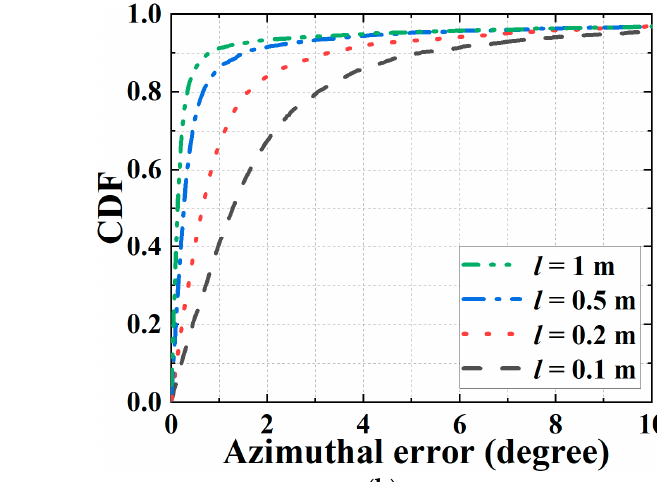
Figure 7. Mean positioning errors and azimuthal errors at the height of 1 m. ( θ = 0 ◦ ).